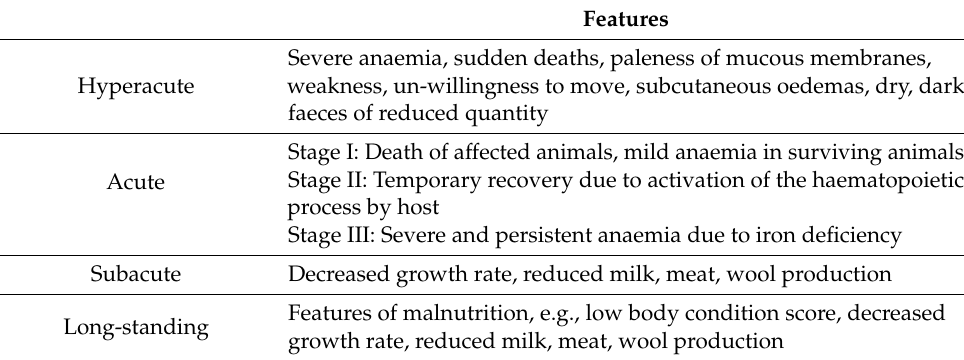
Table 3. Summary of the clinical features of H. contortus